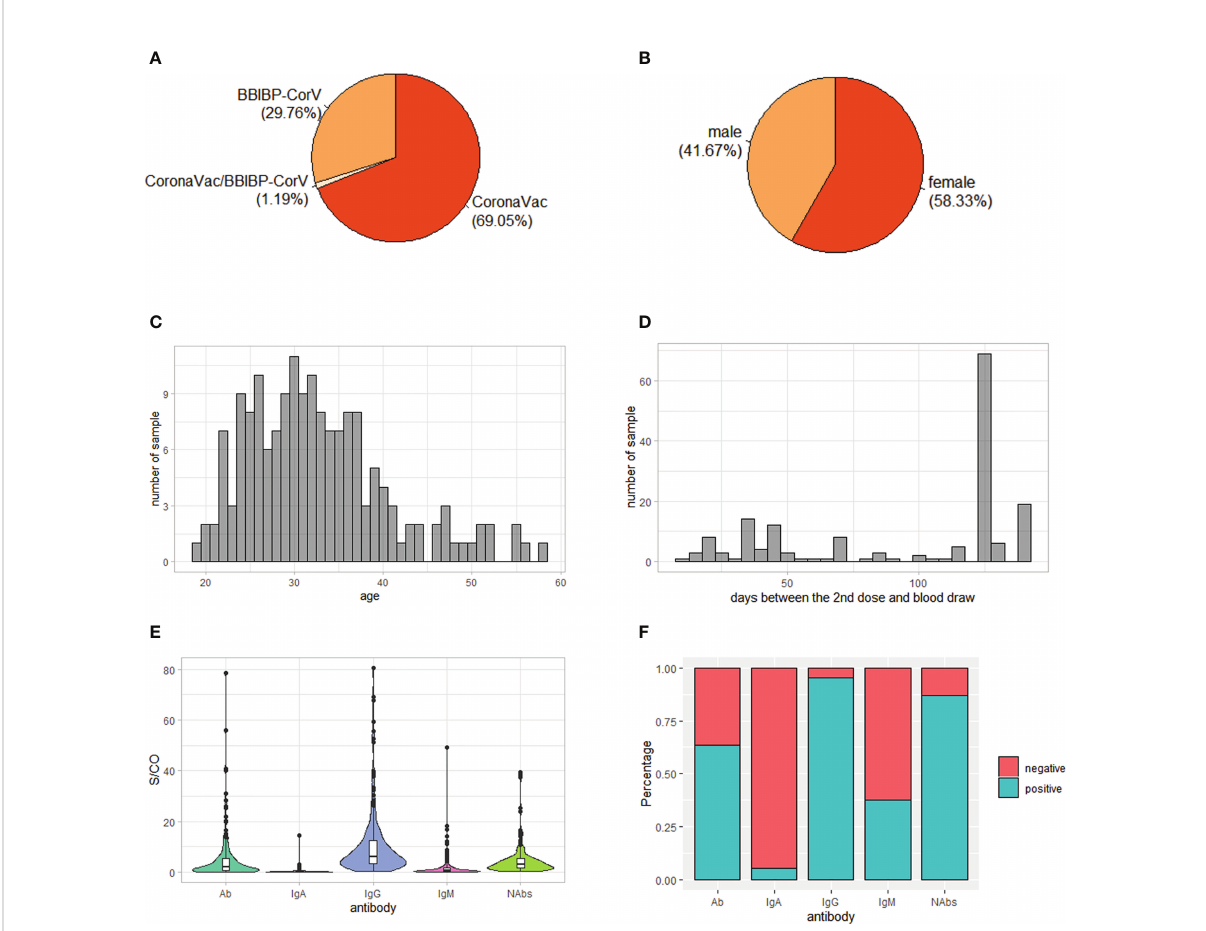
FIGURE 1 Demographic characteristics and antibody levels of the 168 study subjects. (A) Vaccine type distribution; (B) Sex ratio; (C) Age distribution; (D) Distribution of days between the 2nd dose and blood draw; (E) Level of IgG, IgM, IgA, total antibodies (Ab) and neutralizing antibodies (NAbs) S/CO: sample/cutoff. (F) Percentage of positive individuals for IgG, IgM, IgA, Ab and